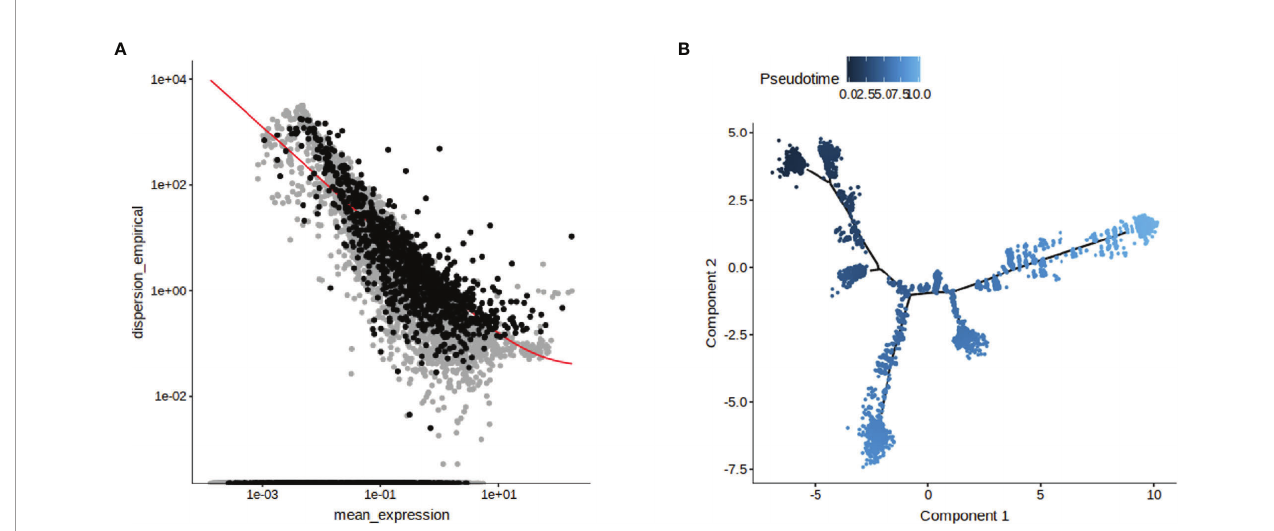
FIGURE 2 | Reconstruction of persistent infecting trajectory through pseudotime analysis. The genes used for the proposed pseudotime trajectory analysis after screening were identi fi ed (A) . DDRTree method was used to show the distribution of pseudotime trajectory in two dimensions (B) . The developmental trajectory of the cells is distinguished by the shade of